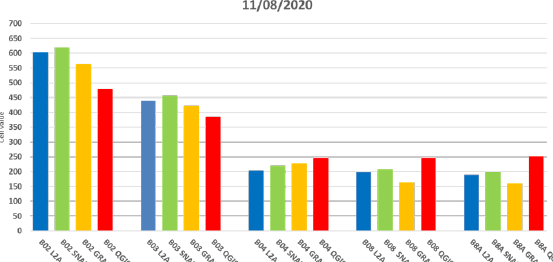
Figure 5. Comparison between L2A products and L1C product corrected in SNAP, GRASS GIS and QGIS software for each analysed band of the day 11 August 2020 (SPE2 station).